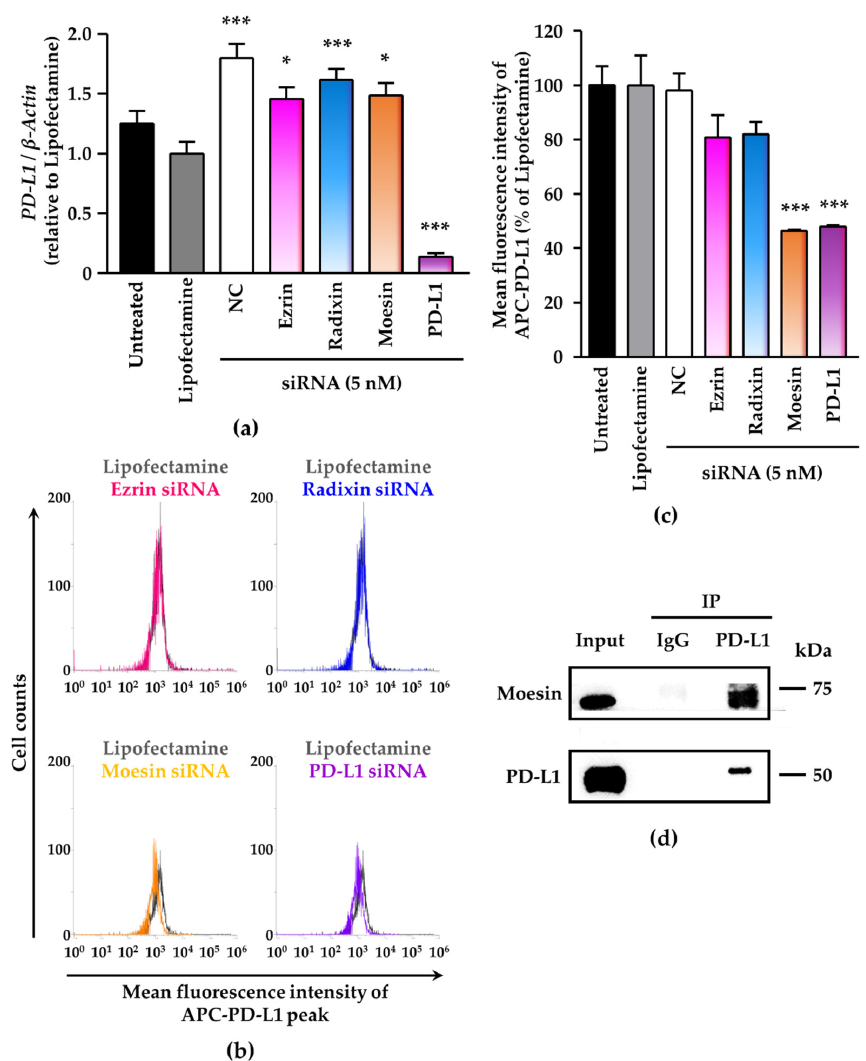
Figure 5. Contribution of moesin to PD-L1 cell surface expression in BOKU cells. Cells were cultured with transfection medium (Untreated), transfection reagent (Lipofectamine), NC siRNA, or the ERM siRNAs for four days ( a – c ). ( a ) PD-L1 mRNA levels normalized to β -actin in cells in all treatment groups relative to that in Lipofectamine-treated cells were determined by RT-PCR; n = 3, *** p < 0.001, * p < 0.05 vs. Lipofectamine. All data are expressed as mean ± SEM and were analyzed by one- way ANOVA followed by Dunnett’s test. ( b ) Overlay of representative histograms of the mean fluorescence intensity of allophycocyanin (APC)-labeled PD-L1 on the surface plasma membrane of BOKU cells as measured by flow cytometry. ( c ) Mean fluorescence intensity of APC-PD-L1 on the surface plasma membrane, quantified by flow cytometry, for all treatments relative to Lipofectamine treatment; n = 3, *** p < 0.001 vs. Lipofectamine. All data are expressed as mean ± SEM and were analyzed by one-way ANOVA followed by Dunnett’s test. ( d ) Representative immunoblots of moesin and PD-L1 in whole-cell lysates (input) and immune precipitates pulled down by a control IgG or an anti-PD-L1 antibody. Molecular weight is expressed in